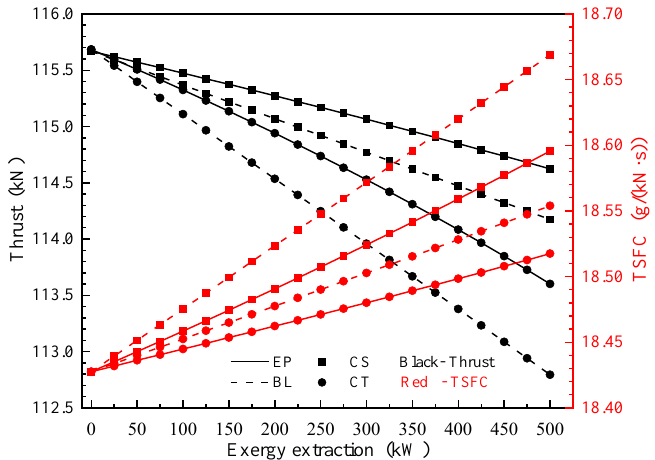
Figure 4. Influence of exergy extraction on engine performance parameters (EP, electric power extraction; BL, bleed air; CS, constant engine speed; CT, constant turbine front